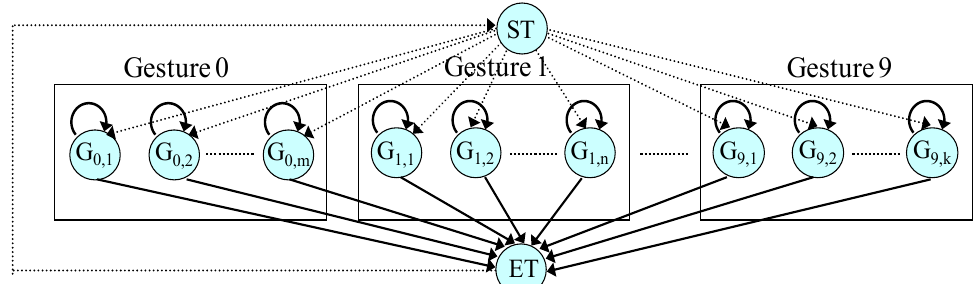
Figure 8. Non-gesture (garbage) model that includes two dummy states (ST and ET); the dotted arrows show null transitions, and G i , j represents the state j with respect to number gesture i .